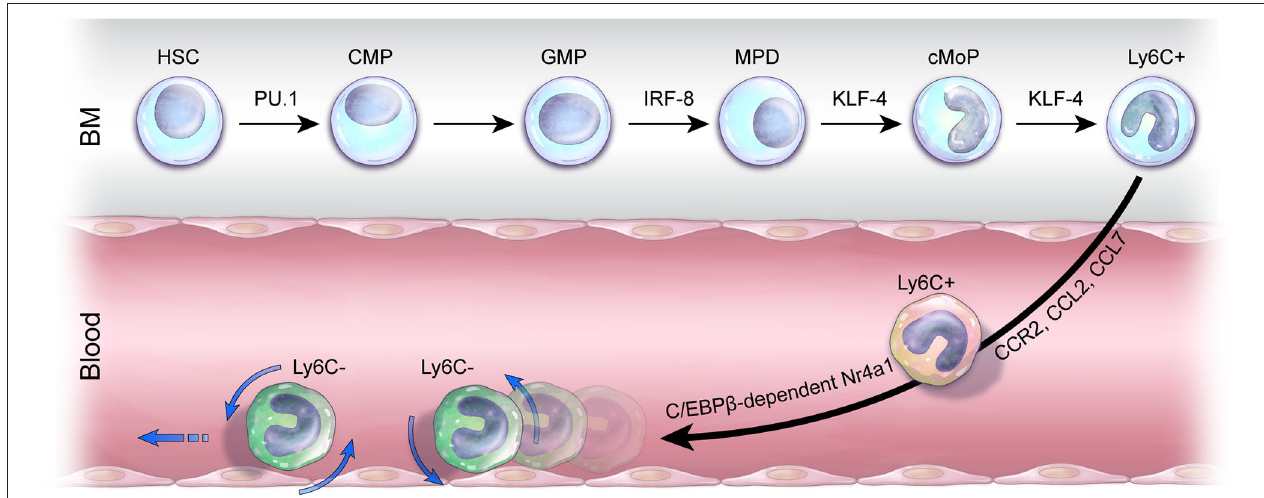
FIGURE 1 | Monocyte development and mobilization. In the bone marrow (BM), pro-inflammatory Ly6C + monocytes are derived from cMoPs that are differentiated from a series of hematopoietic stem cells (HSCs) by transcription factors PU.1, interferon regulatory factor 8 (IRF8), and Kruppel-like factor 4 (KLF4). Ly6C + monocytes emigrate out of the BM in a C-C chemokine receptor 2 (CCR2)-dependent manner, and the ligands of CCR2, C-C motif ligand 2 (CCL2) and C-C motif ligand 7 (CCL7), stimulate Ly6C + monocyte mobilization into the blood. The development of anti-inflammatory Ly6C − monocytes from Ly6C + monocytes depends on CCAAT enhancer–binding protein β (C/EBP β )–dependent nuclear receptor subfamily 4 group A member 1 (NR4A1). Ly6C − monocytes crawling on the endothelium in the periphery act in an immune surveillance capacity to maintain